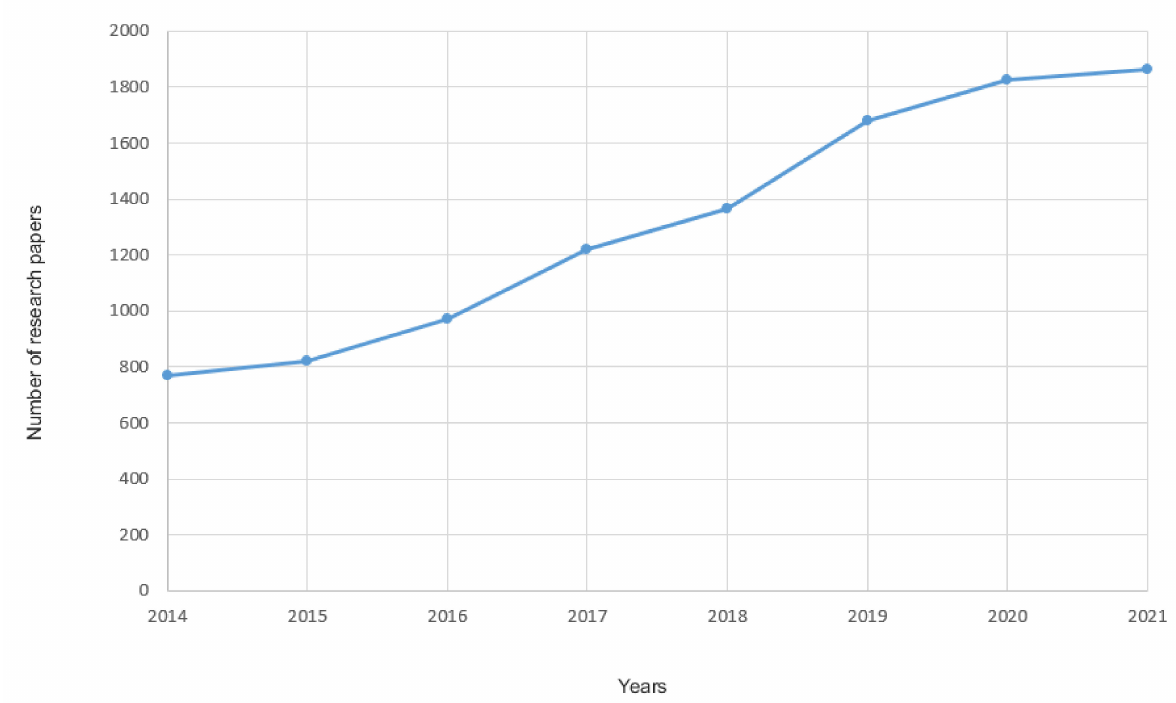
Figure 12. Timeline of research papers in the field of thermal/cooling energy storage from the year 2014 onward (source: Scopus